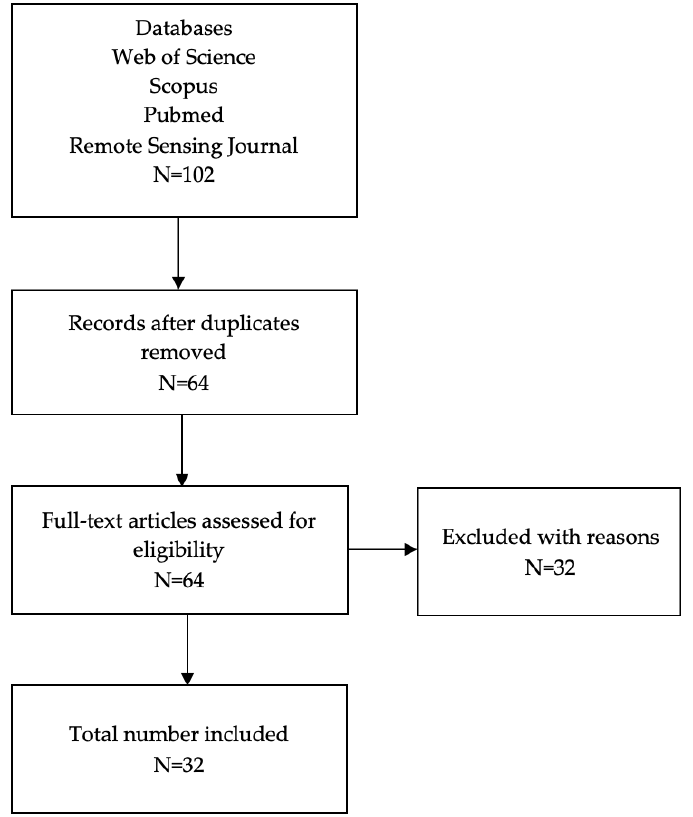
Figure 1. Flow chart on study selection process.